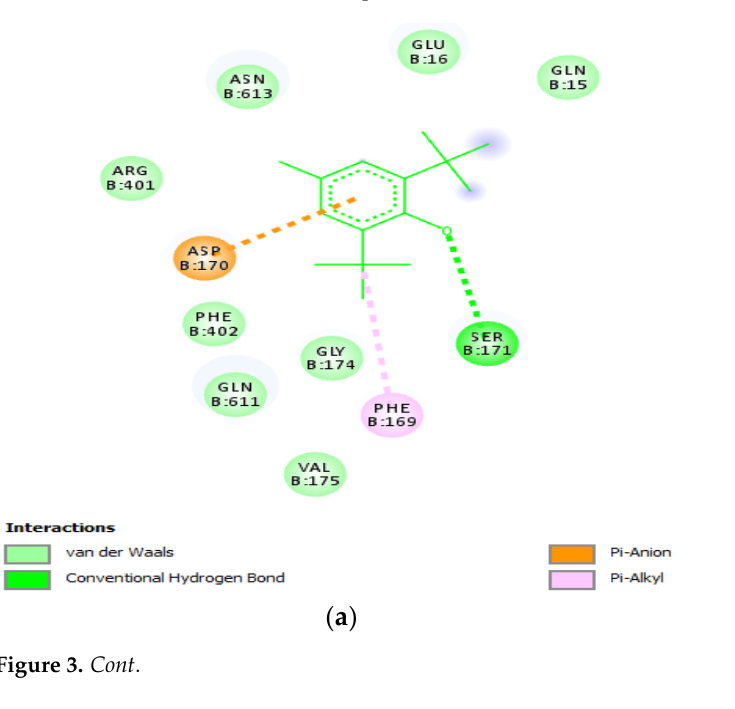
Table 2. Binding affinity for docked poses using AutoDock Vina.